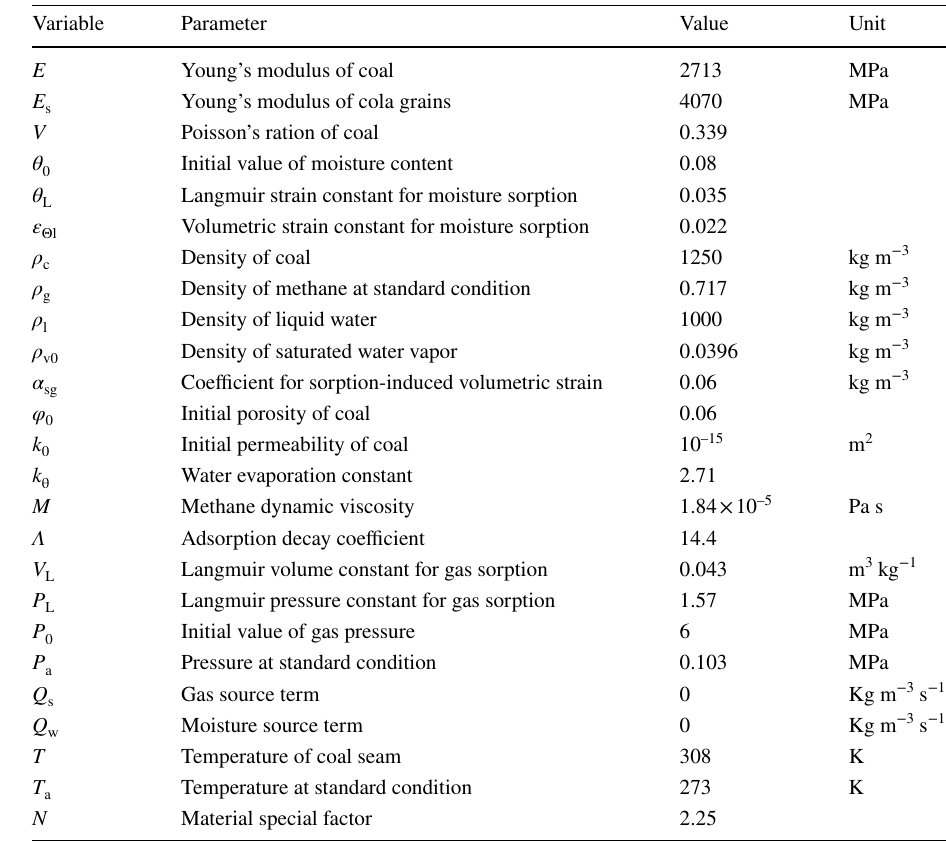
Table 3 Parameters used in the governing